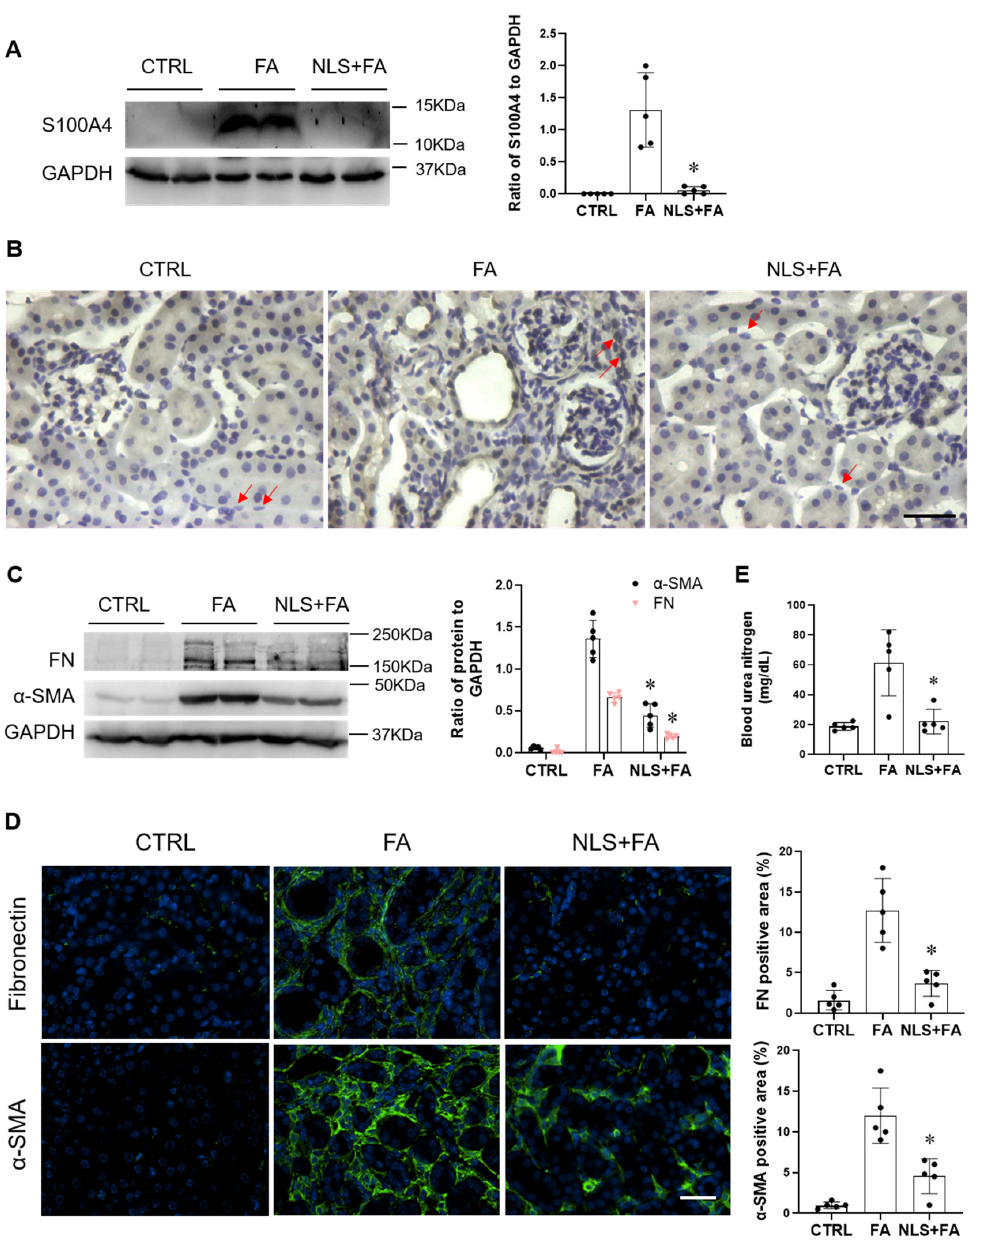
Figure 2. Niclosamide ameliorates renal fibrosis in folic acid nephropathy. ( A ) Western blots show protein levels of S100A4 in the kidneys of mice at day 14 after FA administration (left panel), and quantitative analysis of S100A4 protein levels in the kidneys of mice with FA administration (right panel). ( B ) Representative images of kidney sections immunostained for Smad3 (brown) and coun- terstained with hematoxylin (blue) in mice administered with vehicle (CTRL), FA, or Niclosamide (NLS) + FA. Red arrow indicates the Smad3 staining in the nucleus of tubulointerstitial cells. ( C ) Western blots show α -SMA and fibronectin protein levels in the kidneys at day 14 after CTRL, FA and NLS + FA administration ( left ). Quantitative analysis of fibronectin and α -SMA-positive cells in the kidneys of mice administered with CTRL, FA, or NLS + FA ( right ). ( D ) Representative images of fibronectin and α -SMA expression in kidney of mice administered with CTRL, FA, or NLS + FA (left panel). Quantitative analysis of fibronectin and α -SMA positive cells in kidney sections of mice administered with CTRL, FA, or NLS + FA (right panel). Scale bar = 50 µm. ( E ) Blood urea nitrogen (BUN) levels in mice at day 14 after CTRL, FA and NLS + FA administration. Data are expressed as Mean ± SEM, n = 5 per group. * p < 0.05 vs. FA group.